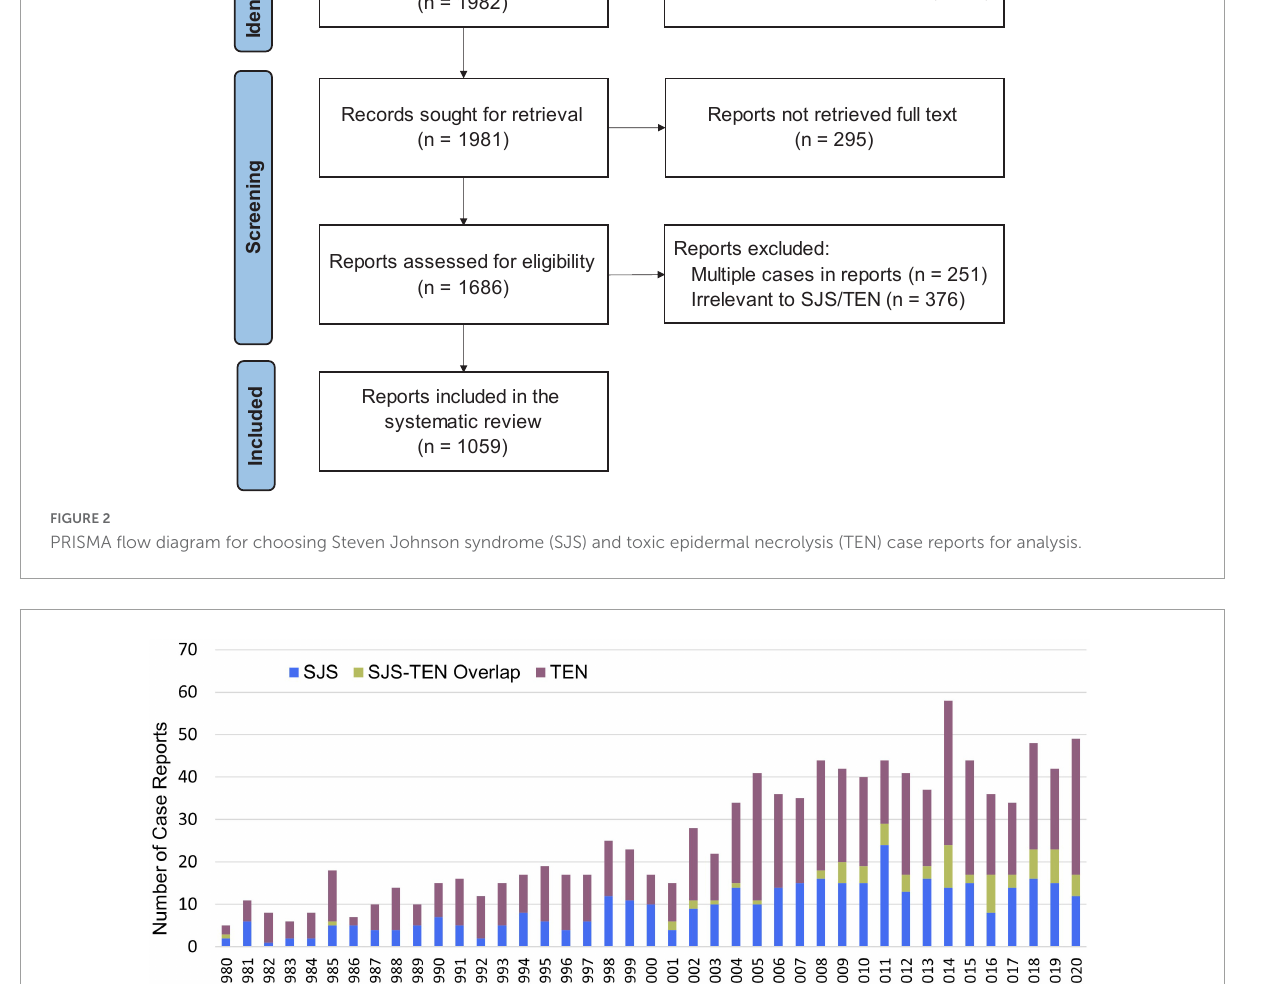
therapy (PD-1, PD-L1, CTLA-4 inhibitors), 97 patients had an autoimmune disease diagnosis (i.e., systemic lupus erythematosus, rheumatoid arthritis, psoriasis), and 52 patients presented with an HIV diagnosis preceding onset. About 20% and 16% of patients diagnosed with TEN and SJS, respectively, were diagnosed with cancer. 2.0% of TEN cases and 2.6% of SJS cases were receiving cancer therapy at the time of their SJS/TEN diagnoses. Altogether, 7 − 10% of cases in all groups were documented to have at least one autoimmune